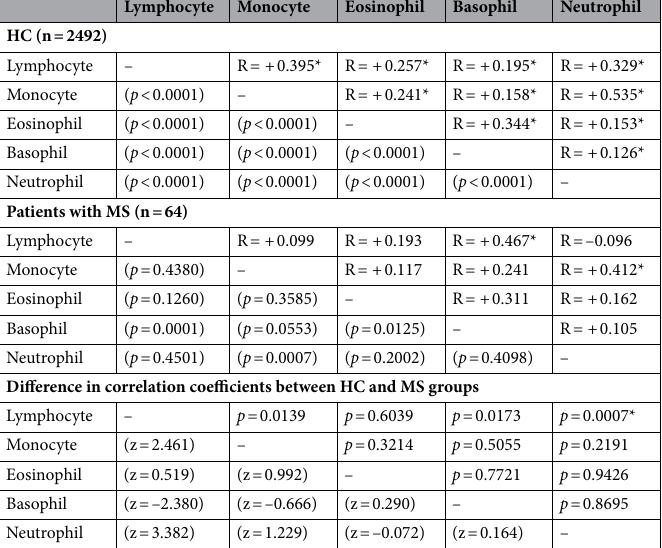
brain lesions. Even when the impact of each differential WBC on disease activity or severity was evaluated based on its percentage [%] (i.e., not the absolute count [/μL]), none of the five cell types showed a significant impact on the disease activity or severity. For reference, the monocyte count showed a weak positive correlation with the value of QAlb (Pearson’s R = + 0.397, p = 0.0039), whereas the other WBC differentials did not.